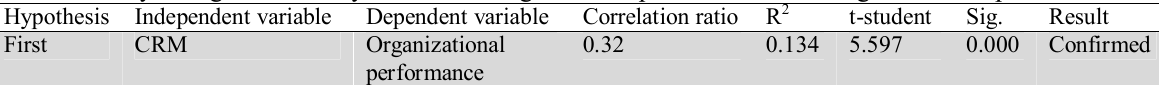
The summary of regression analysis between organization performance and Organizational performance Hypothesis Independent variable